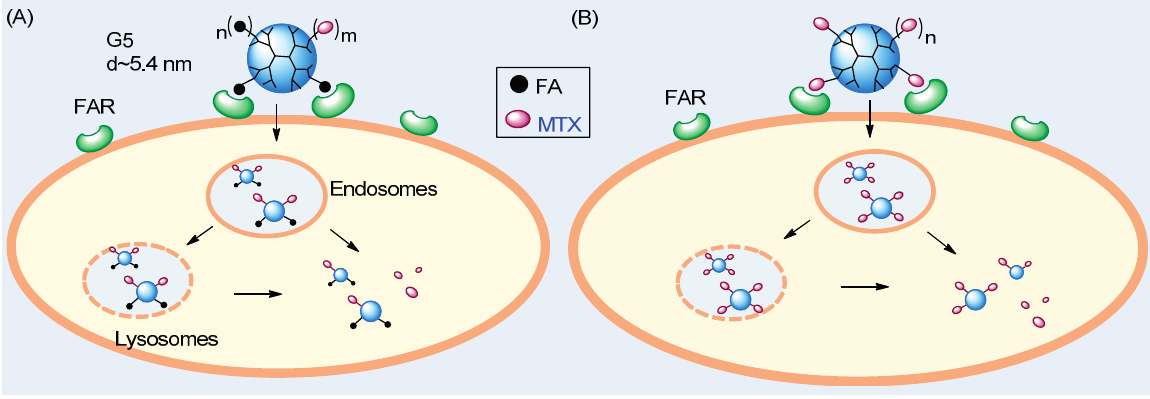
Figure 1. Two strategies for targeted drug delivery to a folate receptor (FAR)-overexpressing tumor cell with a fifth generation (G5) dendrimer NP. ( A ) A conventional two-molecule approach with G5(FA) n (MTX) m presenting folic acid (FA) as a targeting ligand and carrying methotrexate (MTX) as a drug payload and ( B ) A dual-acting, single molecule approach with G5(MTX) n presenting MTX as both a targeting ligand and drug